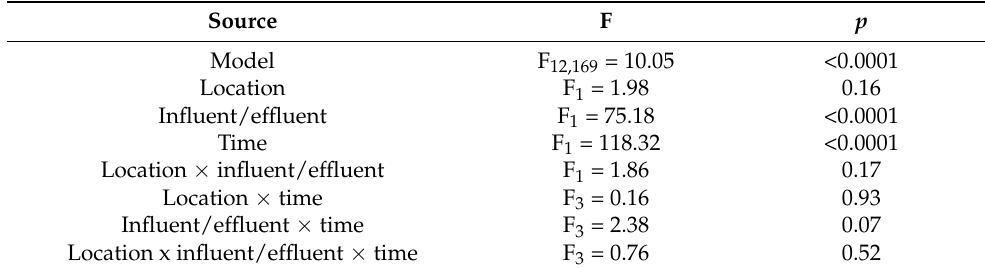
Table 4. Summary of an ANOVA 3 (F and p values) testing the impact of location, influent/influent, and time on antibiotic concentration. Source